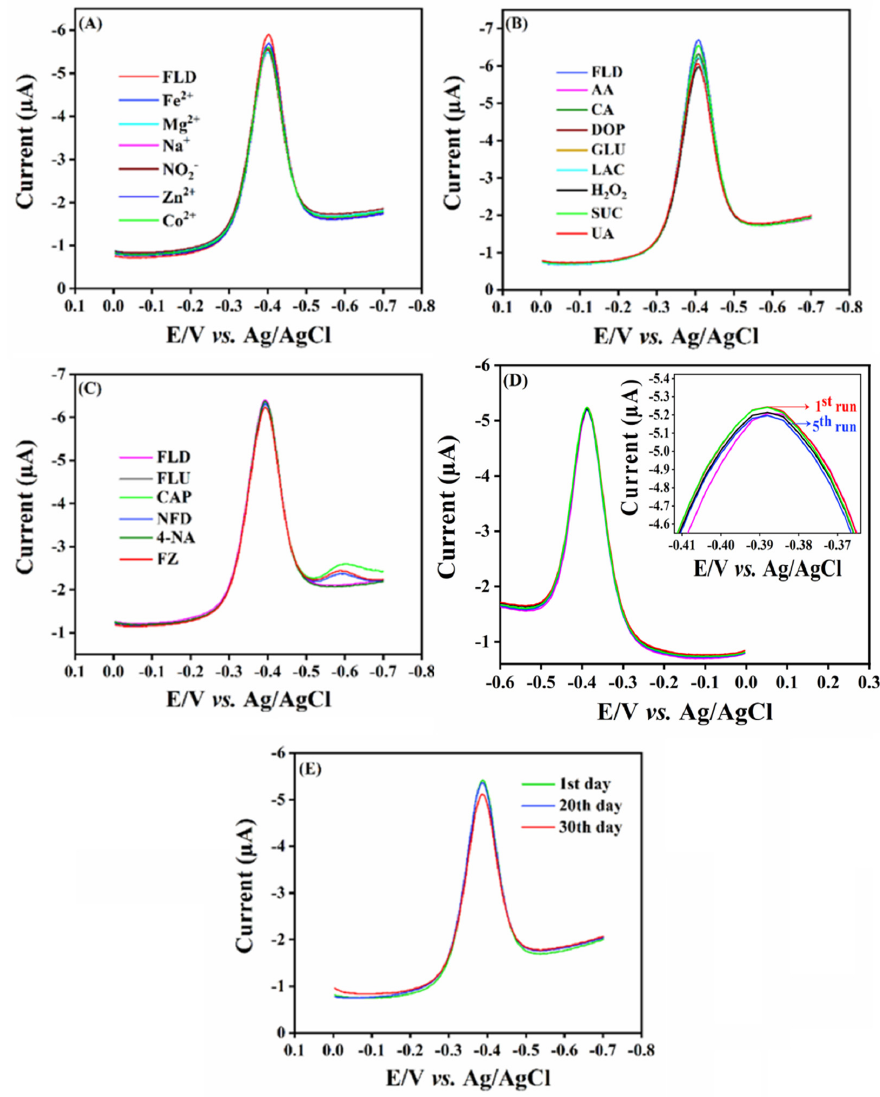
Figure 7. Cathodic current response for SrMnO 3 / f- BN/SPCE with different interfering species, such as ( A ) metals ions, ( B ) biological molecules, and ( C ) nitro group related compounds. ( D , E ) Reproducibility and storage stability of SrMnO 3 / f -BN/SPCE.